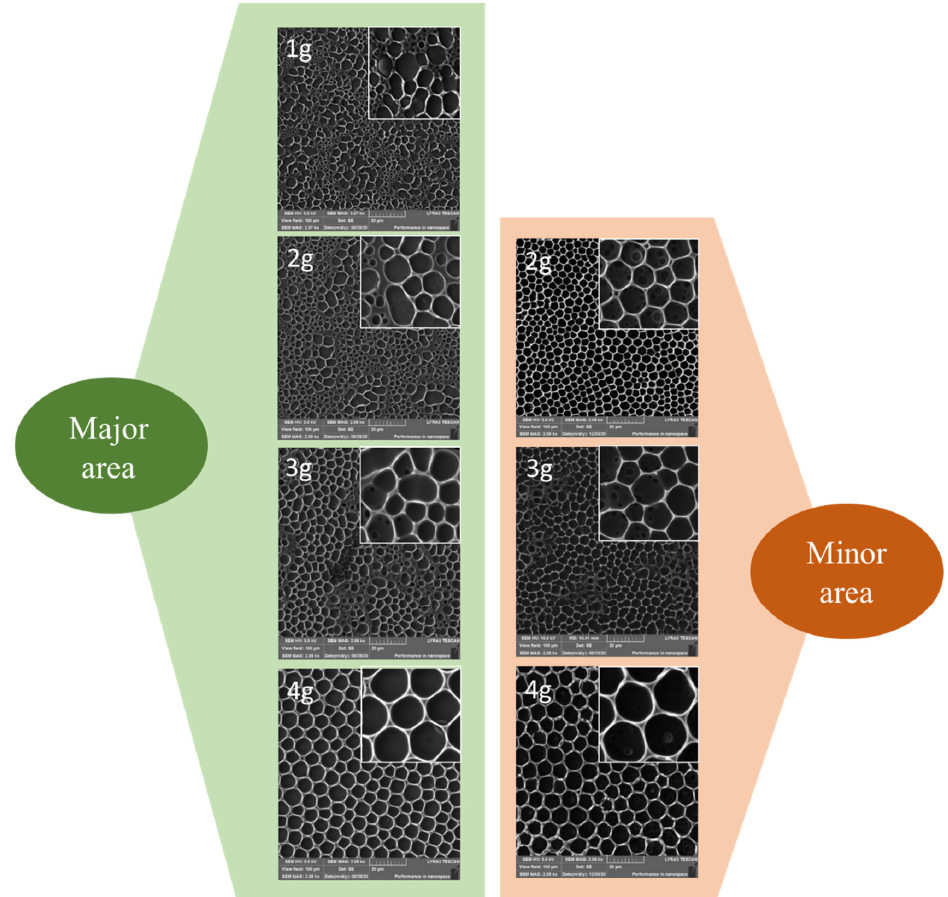
Figure 1. Scanning electron microscopy images of honeycomb-like pattern major and minor areas formed on plasma-modified fluorinated ethylene propylene containing different amounts (1–4 g) of incorporated polymethyl methacrylate. The scanned areas were 100 × 100 µm 2 .